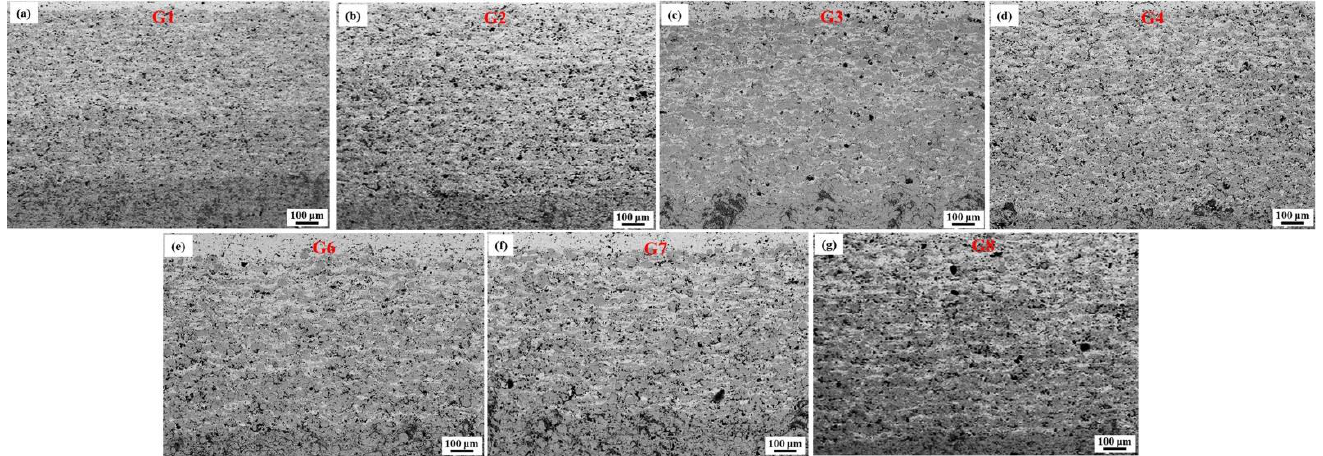
Figure 3. Higher magnification images of gradient layer in the NiCoCrAlY/YSZ coating: ( a ) G1, ( b ) G2, ( c ) G3, ( d ) G4, ( e ) G6, ( f ) G7 and ( g ) G8.